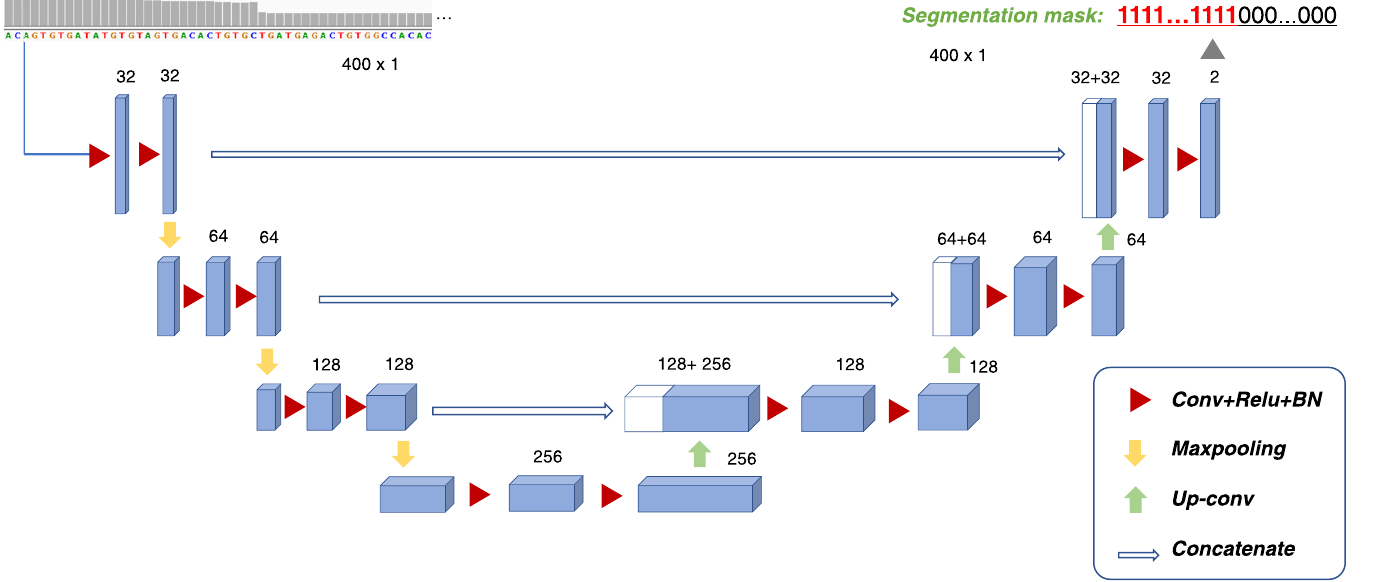
Fig 2. Model structure of the deep segmentation model UNet used for labeling SV overlapping coordinates.